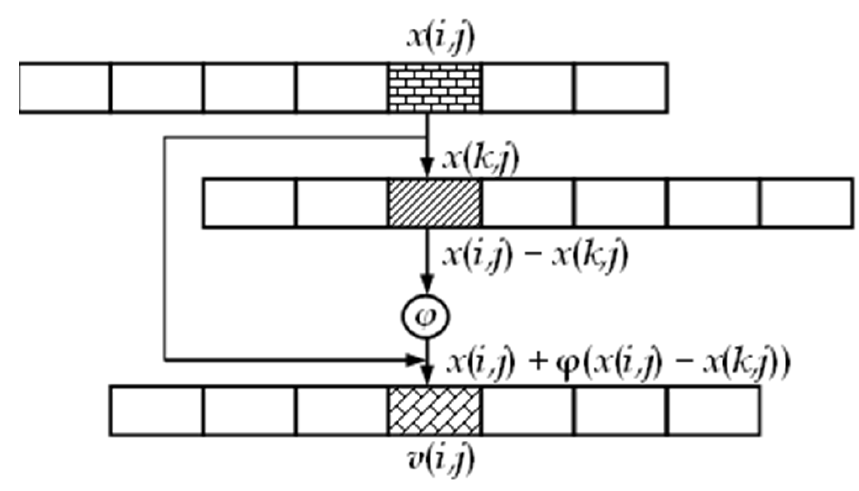
Figure 2. A simple position update scheme.